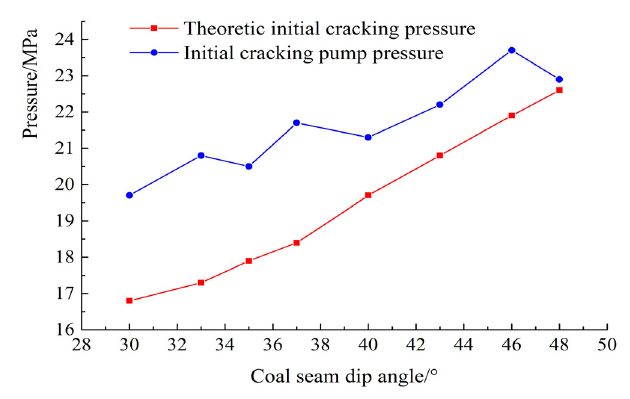
Figure 15. Pressure change in the borehole.